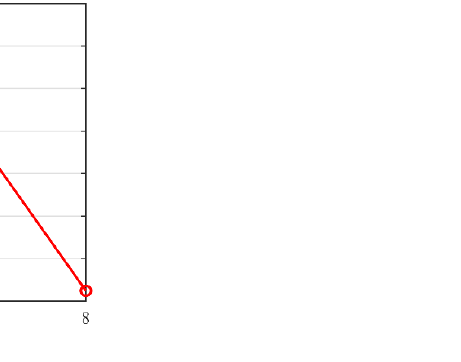
Figure 14. The average forward thrust of the conventional submerged glider under the different K.